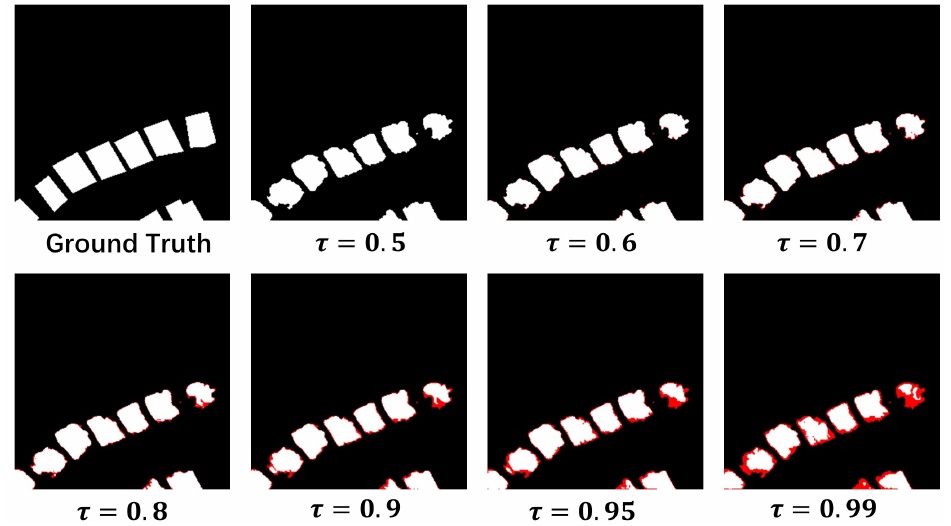
Figure 4. The red part is masked because it is smaller than τ and does not participate in the loss